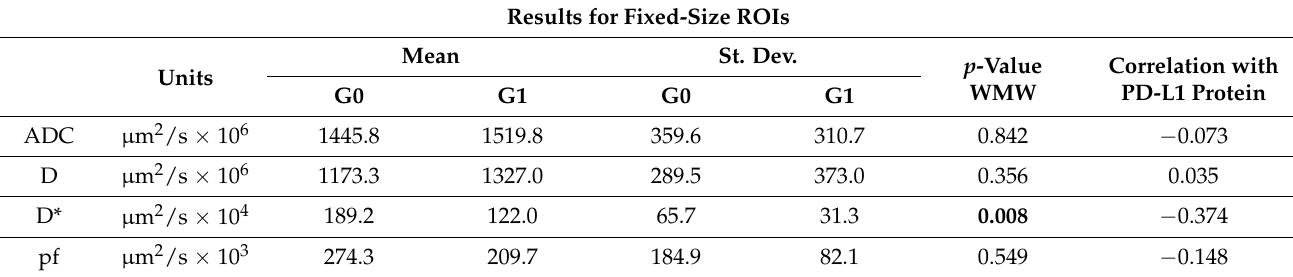
Table 2. Results for fixed-size ROIs computed with algorithm 0. G0 refers to no expression of PD-L1 and G1 refers to the positive expression of PD-L1.